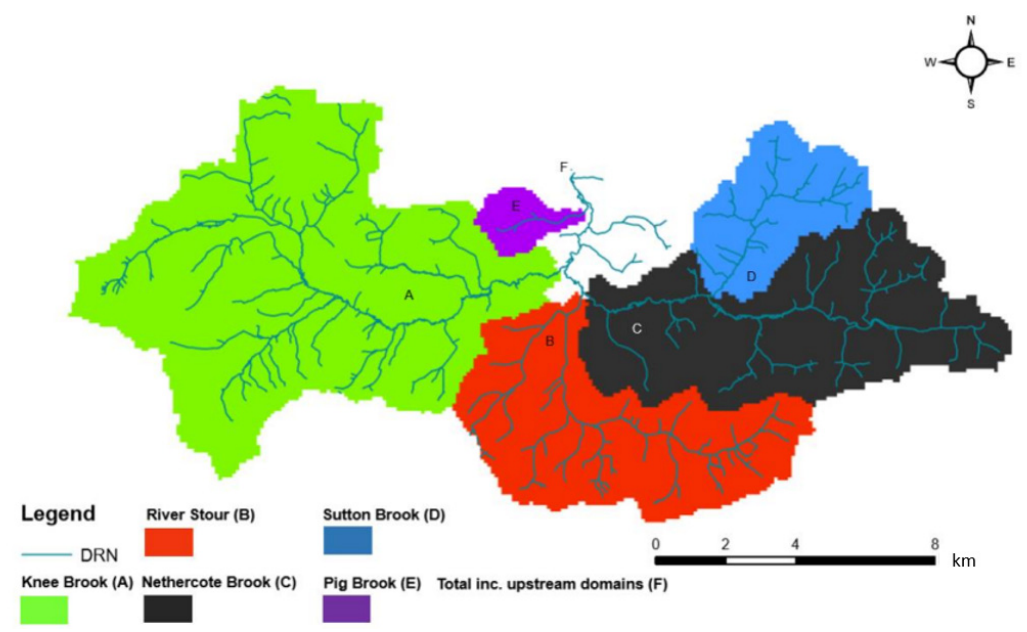
Figure 5. Modelled domains across the Stour Valley.